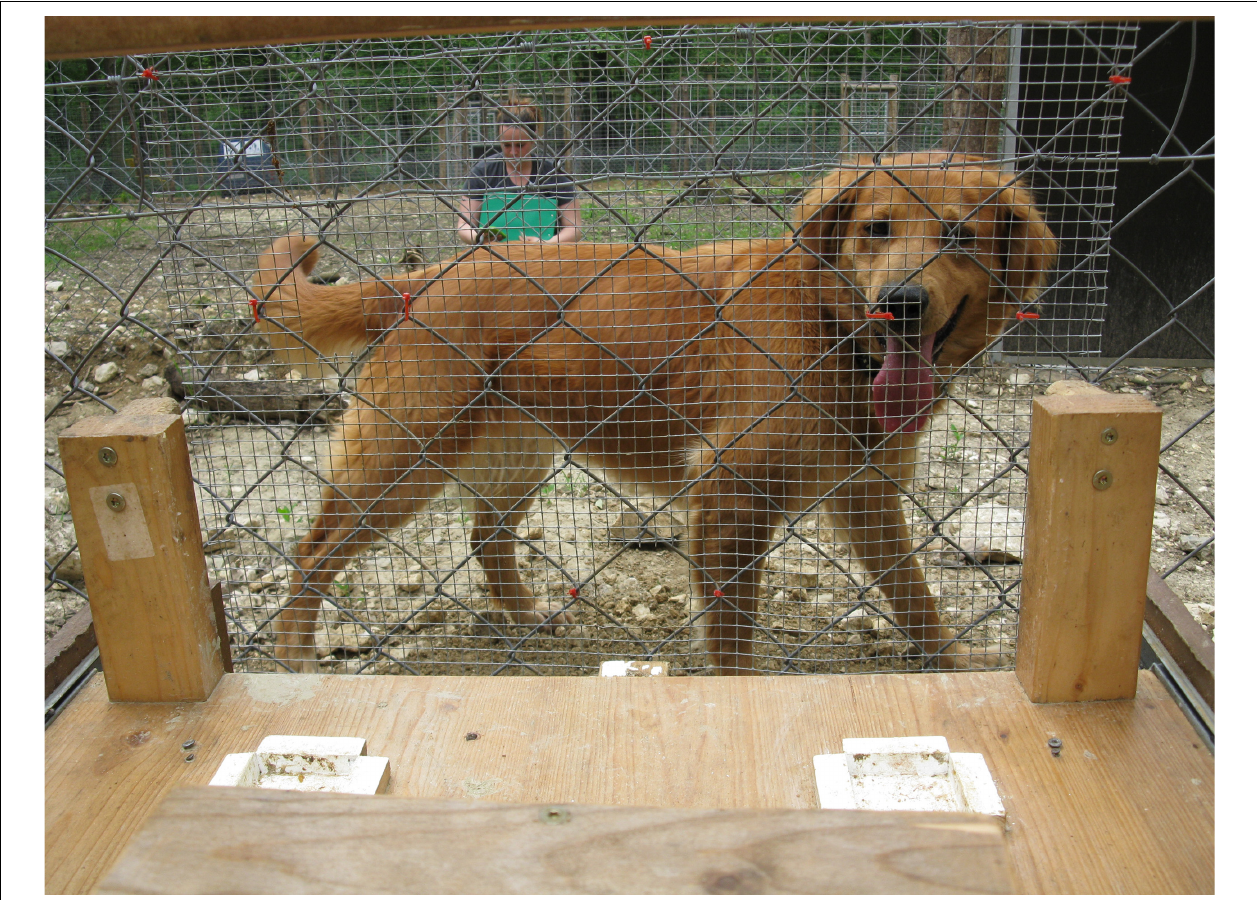
FIGURE 1 | The apparatus: two wooden blocks (targets), were placed adjacent to the food locations (white squares). When the table-top was slid forward animals could touch one of the targets with either nose or paw, which resulted in the researcher delivering the food item from the corresponding white square.